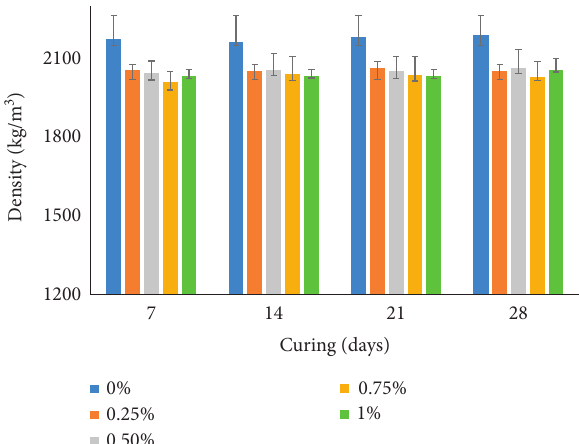
Figure 3: Dry density of the specimens.